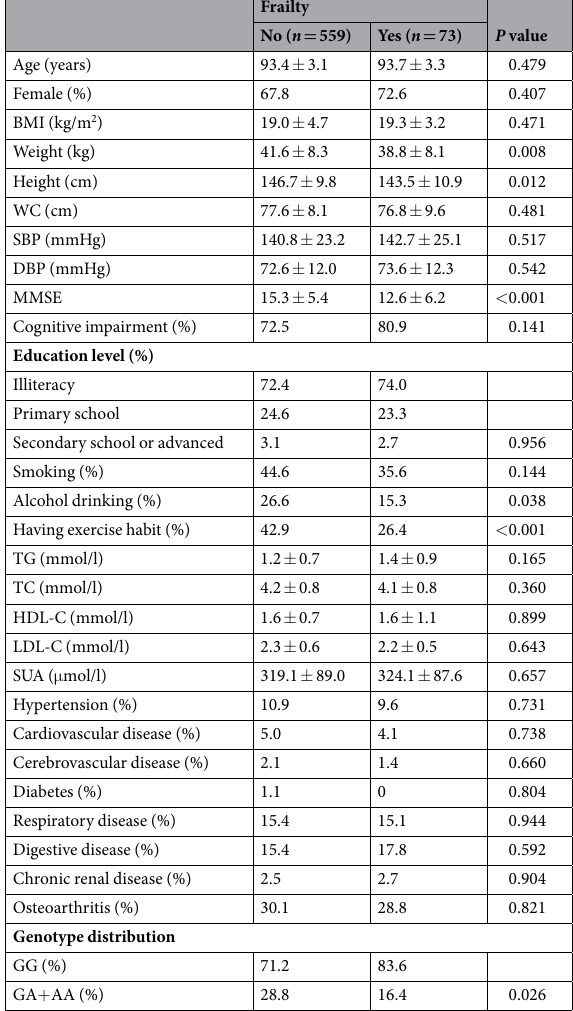
Table 1. Characteristics of the study population according to frailty. Data are presented as the mean ± SD unless otherwise indicated. Abbreviations: BMI, body mass index; CAD, coronary artery disease; HDL-C, high-density lipoprotein cholesterol; LDL-C, low-density lipoprotein cholesterol; MMSE, mini-mental